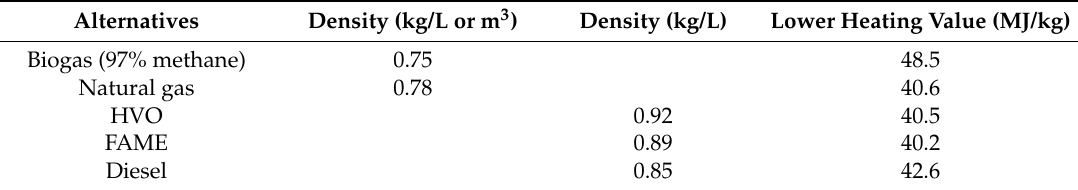
Table 2. Fuel properties